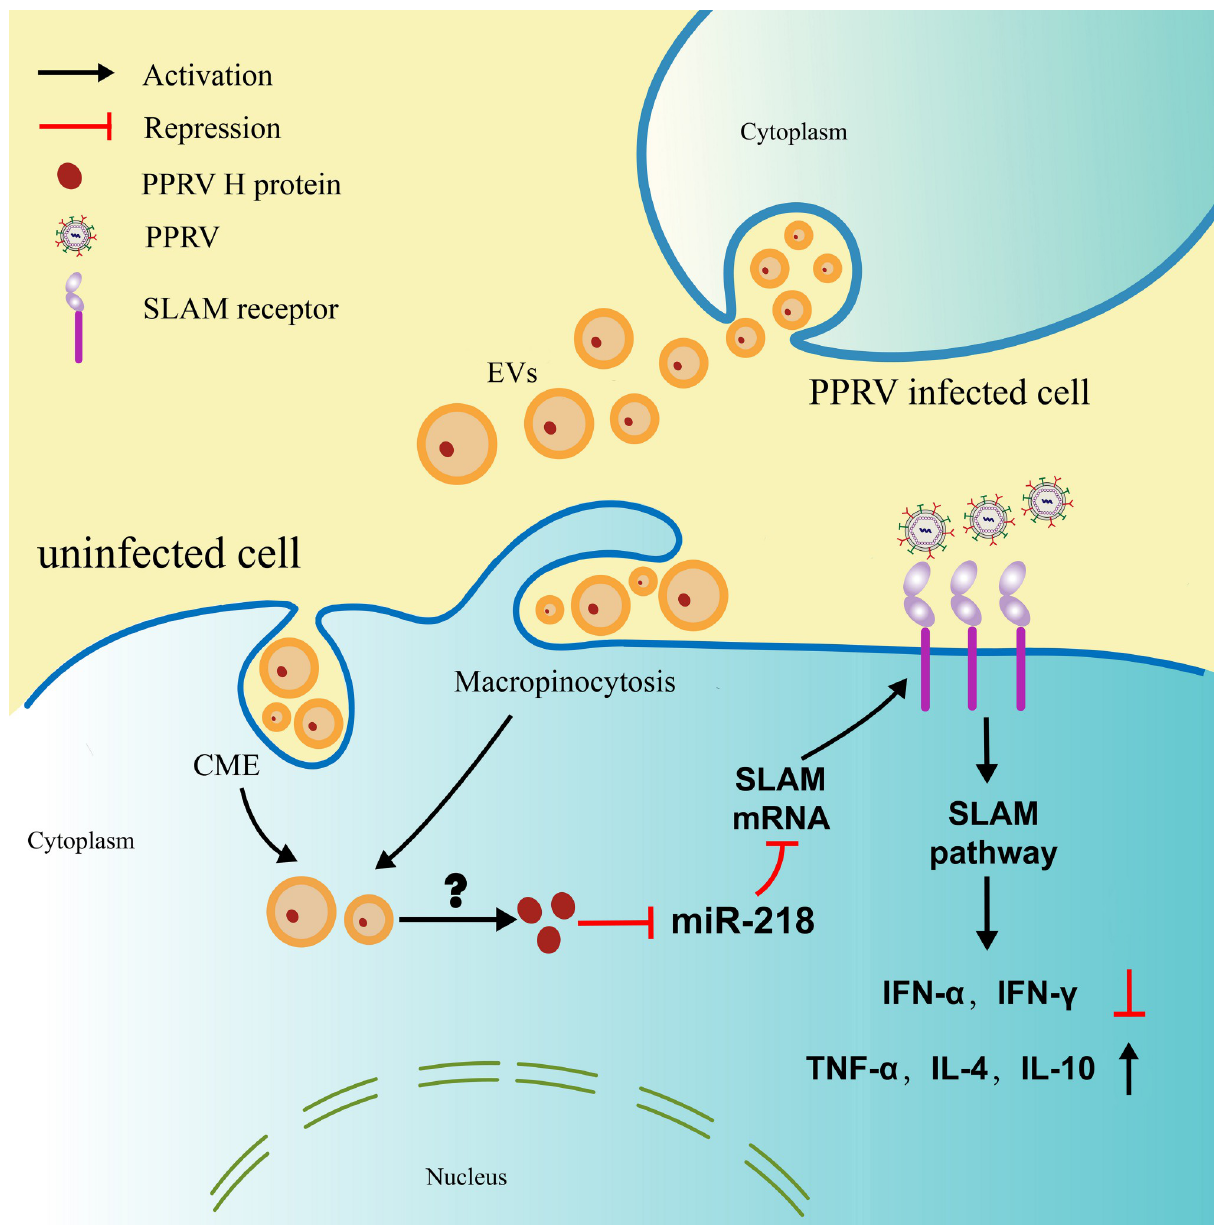
Fig 8. Proposed model for the PPRV H protein-containing extracellular vesicles mediated enhancement of SLAM expression in the recipient cells and regulation of virus invasion. PPRV infection stimulates EVs secretion and EVs entry into the recipient cells mainly via macropinocytosis route and cooperated with caveolin- and clathrin-mediated endocytosis. PPRV H protein contained in extracellular vesicles can enhance miR-218-mediated SLAM expression in the recipient cells, and promote PPRV infection. PPRV associate EVs can regulate SLAM mediated cytokines expression in the recipient